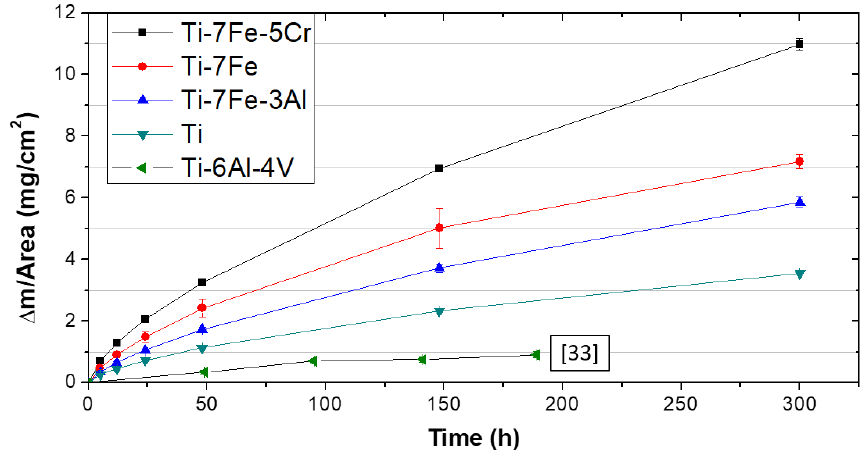
Figure 6. Mass gain as exposure time increase in 600 °C oxidation test for 300 h of Ti ‐ 7Fe ‐ 5Cr, Ti ‐ 7Fe, Ti ‐ 7Fe ‐ 3Al, Ti ‐ 6Al ‐ 4V [33], and unalloyed Ti samples. Backscattered electron images from cross section of the Ti alloys samples tested for 300 h at 600 °C are shown in Figure 7 and mapping and linear chemical composition analysis (EDX) of each oxide layer developed on the surface after been tested for 300 h at 600 °C is also described Figures 8–10.